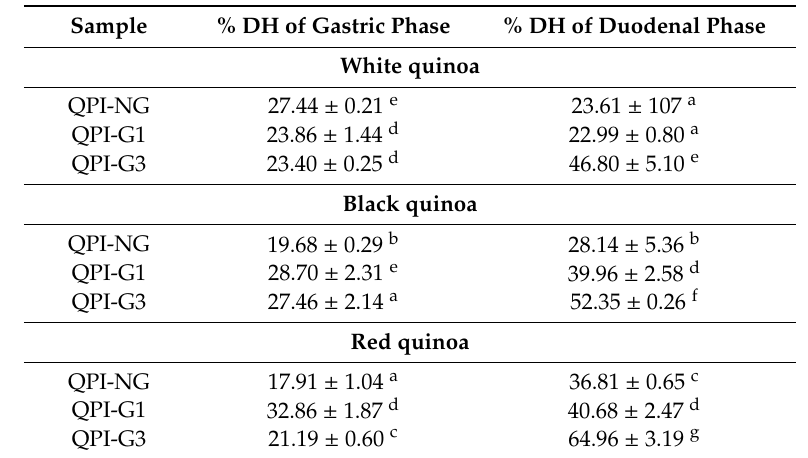
Table 2. Percentage degree hydrolysis (DH) of gastric and duodenal digest from non-germinated and germinated